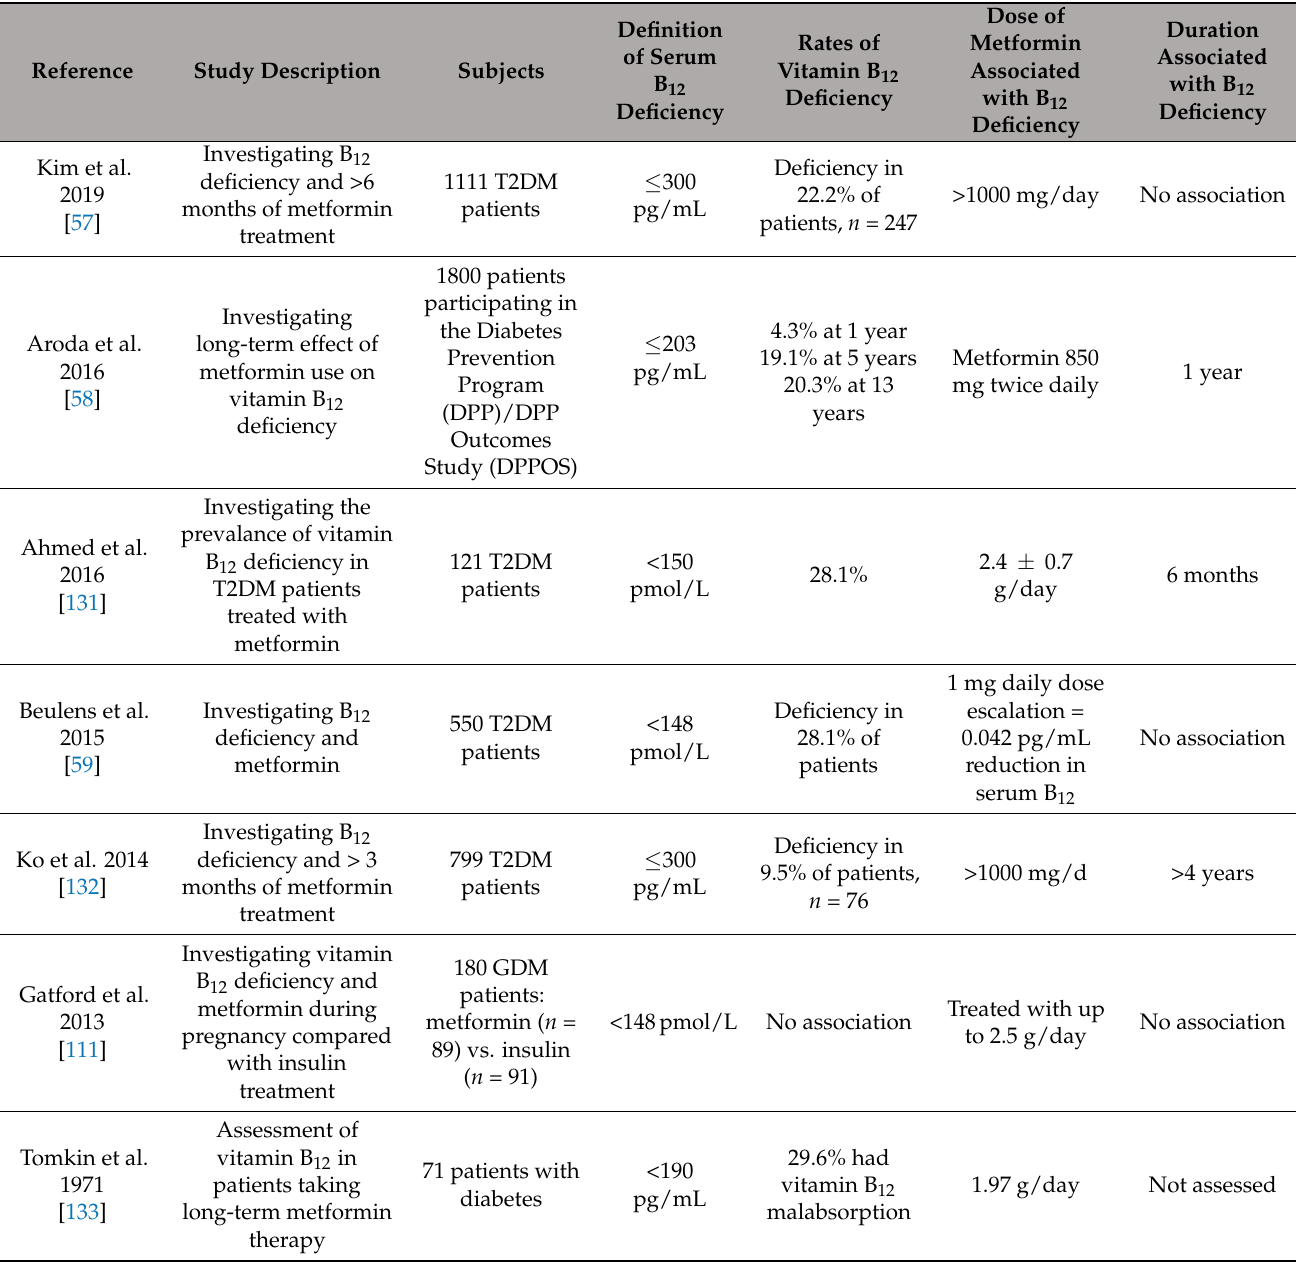
Table 3. Rates of vitamin B 12 deficiency in patients treated with metformin